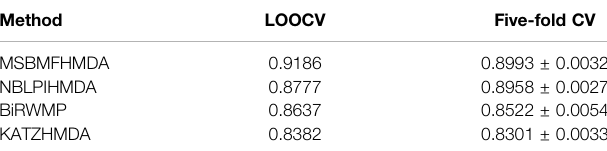
TABLE 3 | Performances of different methods in LOOCV and fi vefold CV.